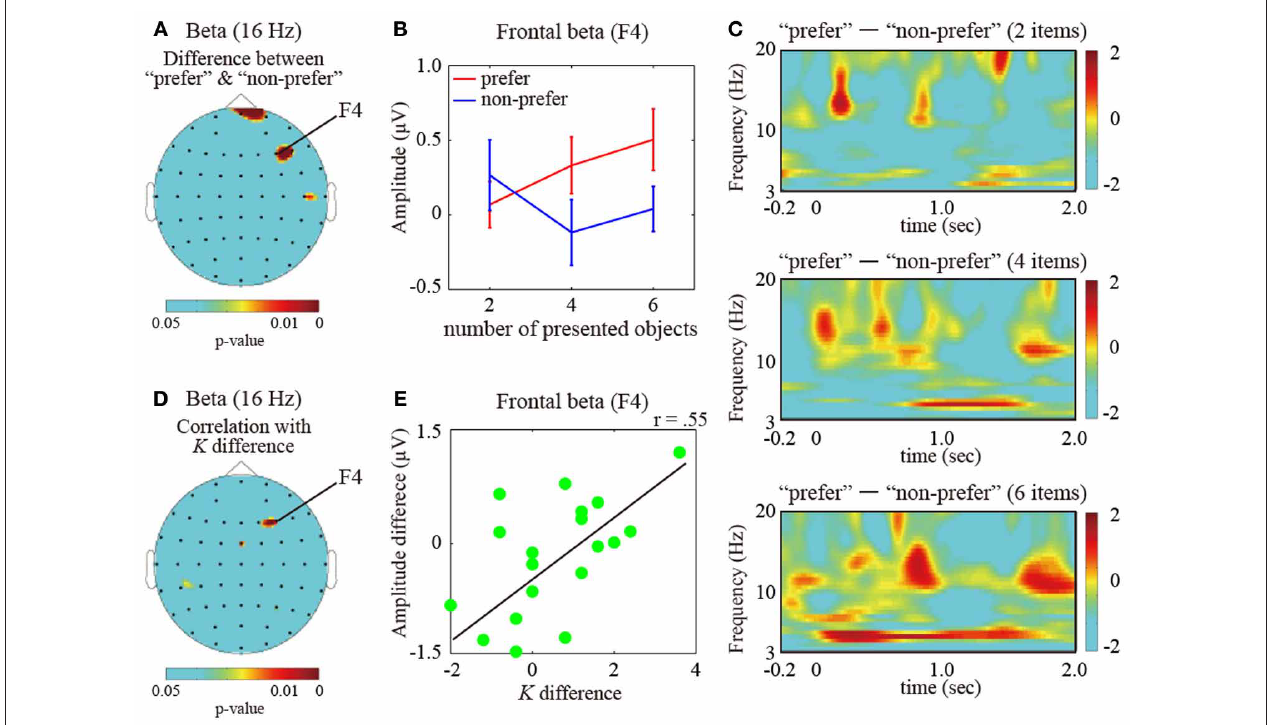
FIGURE 3 | (A) Statistical topographic colored scalp maps showing p -values of the beta (16Hz; frequency measuring the peak statistic value) activation differences between the “prefer” and “non-preferred” conditions. (B) Bar graph showing the subject-averaged amplitude of beta frequency bands at the frontal electrode (F4 electrode measuring the peak statistic value) under the “preferred” (red) and “non-preferred” (blue) conditions. Error bars represent standard errors of the mean. (C) Different time-frequency amplitudes during the retention intervals for “preferred” and “non-preferred” conditions for the maintenance of 2 (top), 4 (middle),